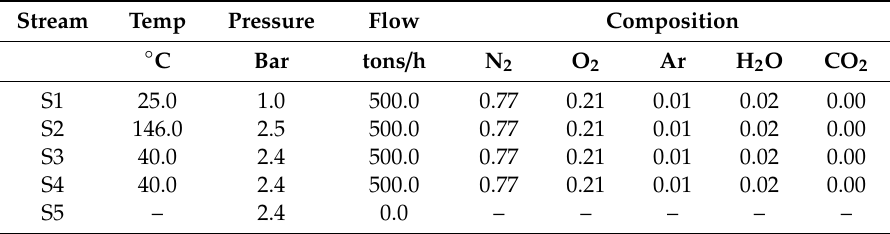
Table 5. Steady-state simulation results for the ASU configuration